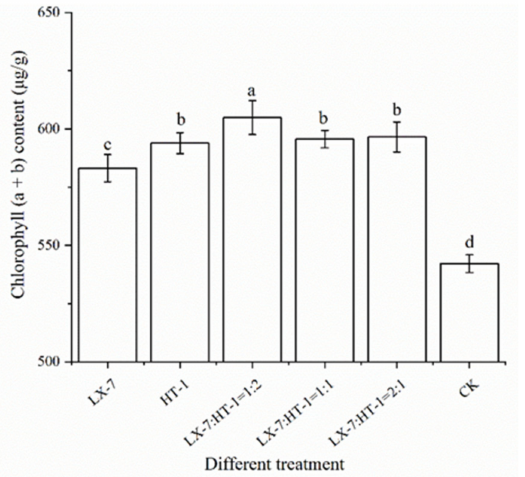
Figure 7. Effect of HT-1 and LX-7 strains on chlorophyll (a + b) content in Brassica chinensis L. plants in greenhouse. Values are mean ± SD (n = 15 plants). Different letters above the bars indicate the differences are significant at p <